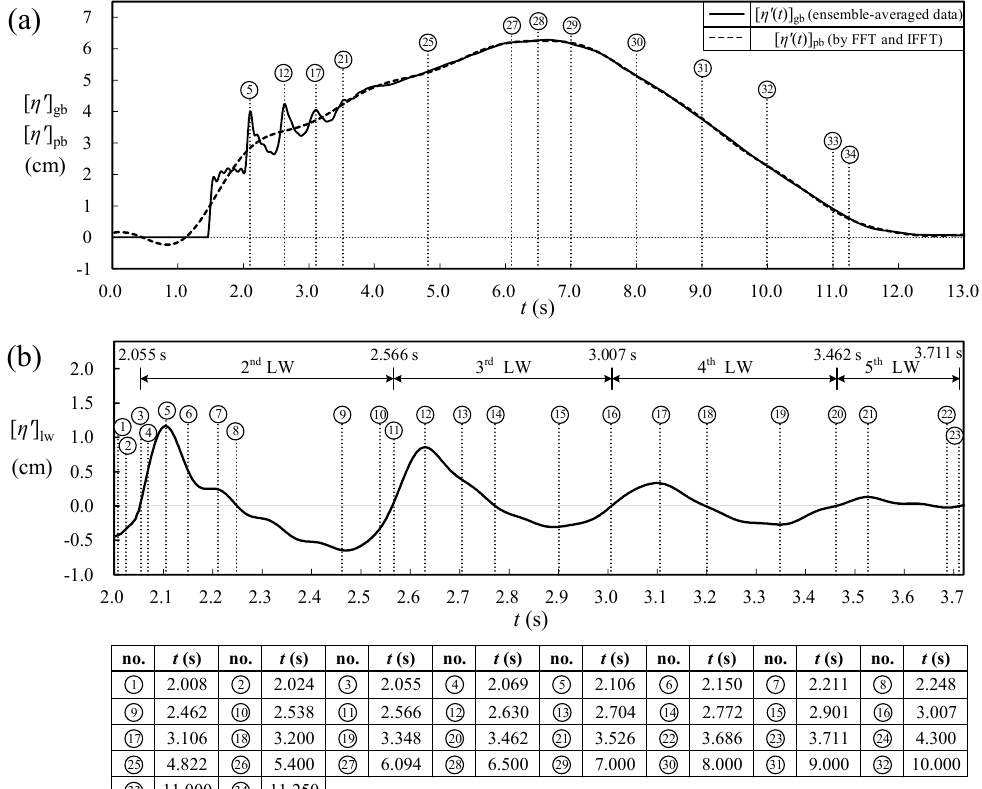
Figure 7. Time series of ensemble-averaged data for free surface elevations of ( a ) generated bore [ η ′ ( t )] gb and pure bore [ η ′ ( t )] pb measured at SMS; ( b ) n th leading waves [ η ′ ( t )] lw (with n = 2–5).